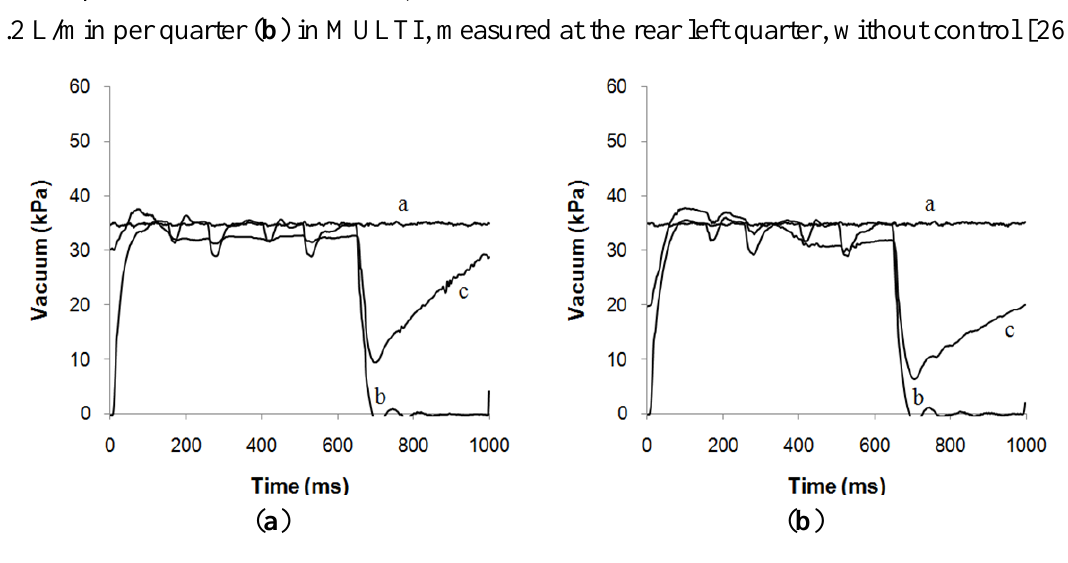
Figure 3. Vacuum changes as a function of time for Line-a: machine vacuum; Line-b: pulsation chamber vacuum; and Line-c: teat-end vacuum at flow rates of 0.5 ( a )